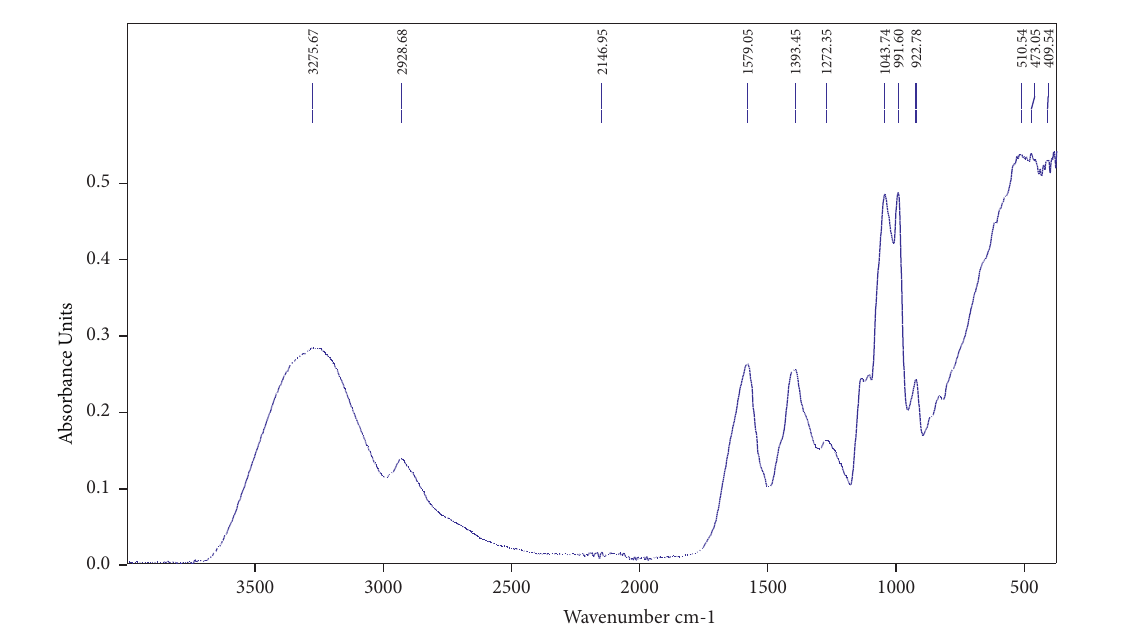
Figure 5: FTIR spectra of Glycine max meal extract. Table 7: Peak wave numbers and